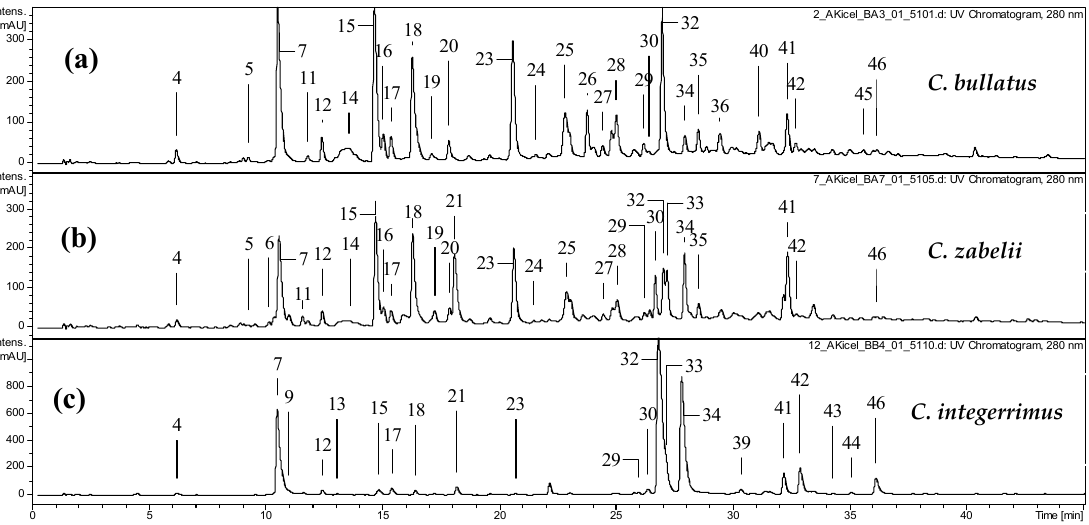
Figure 1. Representative UHPLC-UV chromatograms of the Cotoneaster leaf dry extracts at 280 nm; EAF, the ethyl acetate fractions of C. bullatus ( a ), C. zabelii ( b ) and C. integerrimus ( c ). The peak numbers refer to those applied in Table S1.